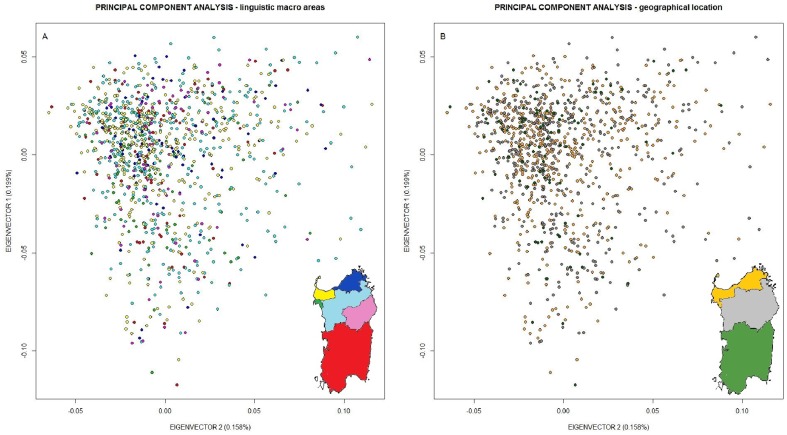
SNP-Based Principal Component Analysis of 1,077 individuals from Sardinia.
Figure 2 A) division accounting linguistic macro-areas. Key of the colors: red: Campidanese; green: Alghero; deep blue: Gallurese; light blue: Logudorese; yellow: Sassarese; purple: Nuorese. Figure 2 B) division accounting geographical areas. Key of the colors: green: Southern Sardinia; grey: Central Sardinia; yellow: Northern Sardinia.